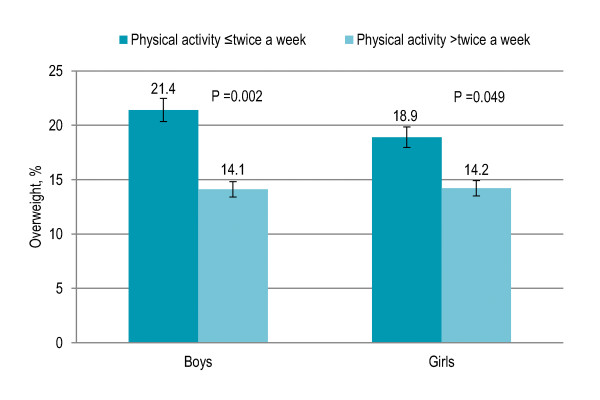
Gender-specific trend in physical activity and prevalence of overweight among Pakistani primary school boys (n = 977) and girls (n = 883). Physical activity included running or jogging, cycling, housework or yard work, and sports involving physical movement (see details in methods).